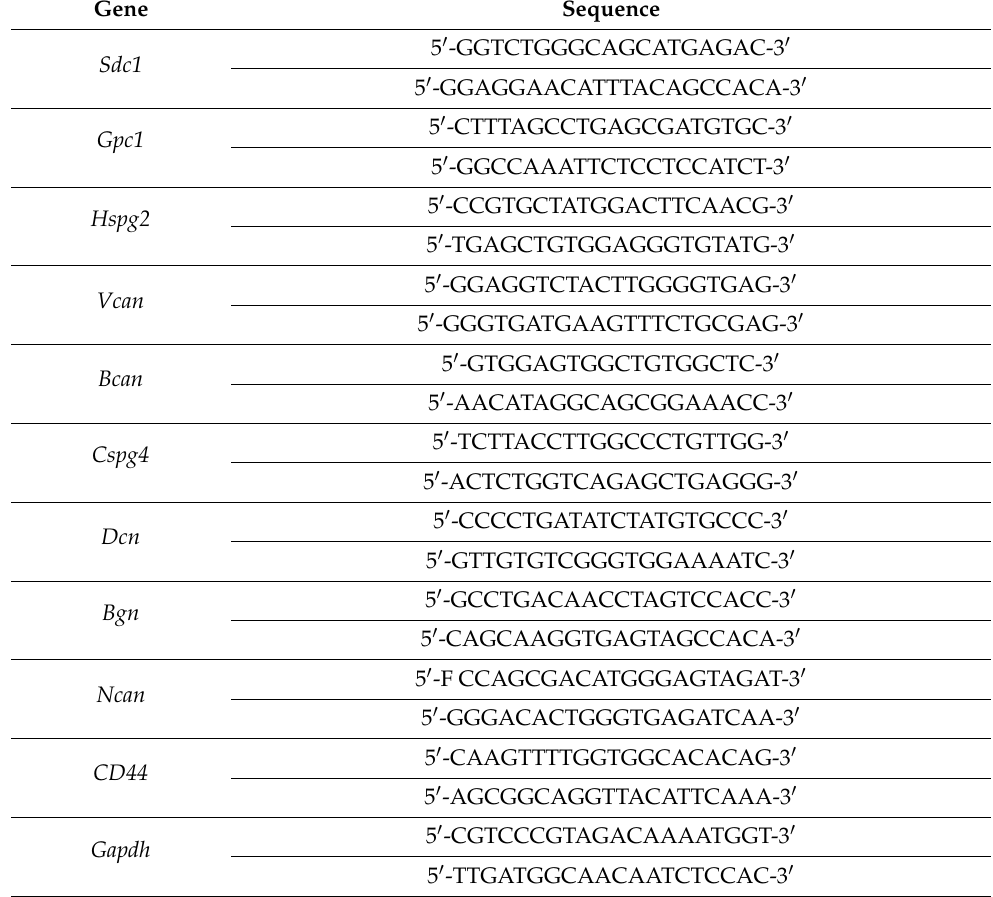
Table 1. Sequences of primers used in PCR